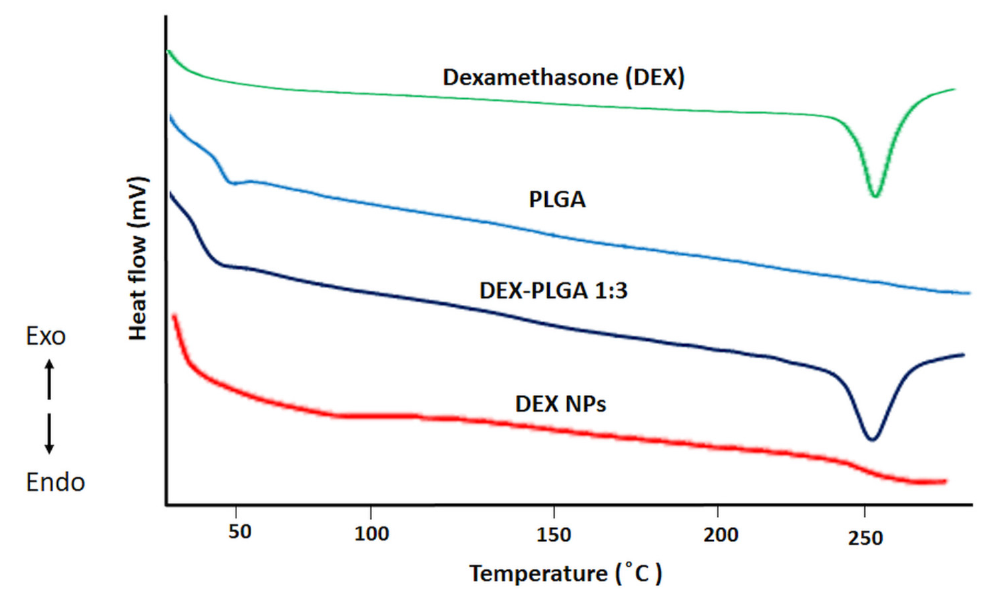
Figure 3. DSC thermograms of Dexamethasone, PLGA, their physical mixture (1:3 ratio), and DEX- Figure 3. NPs.